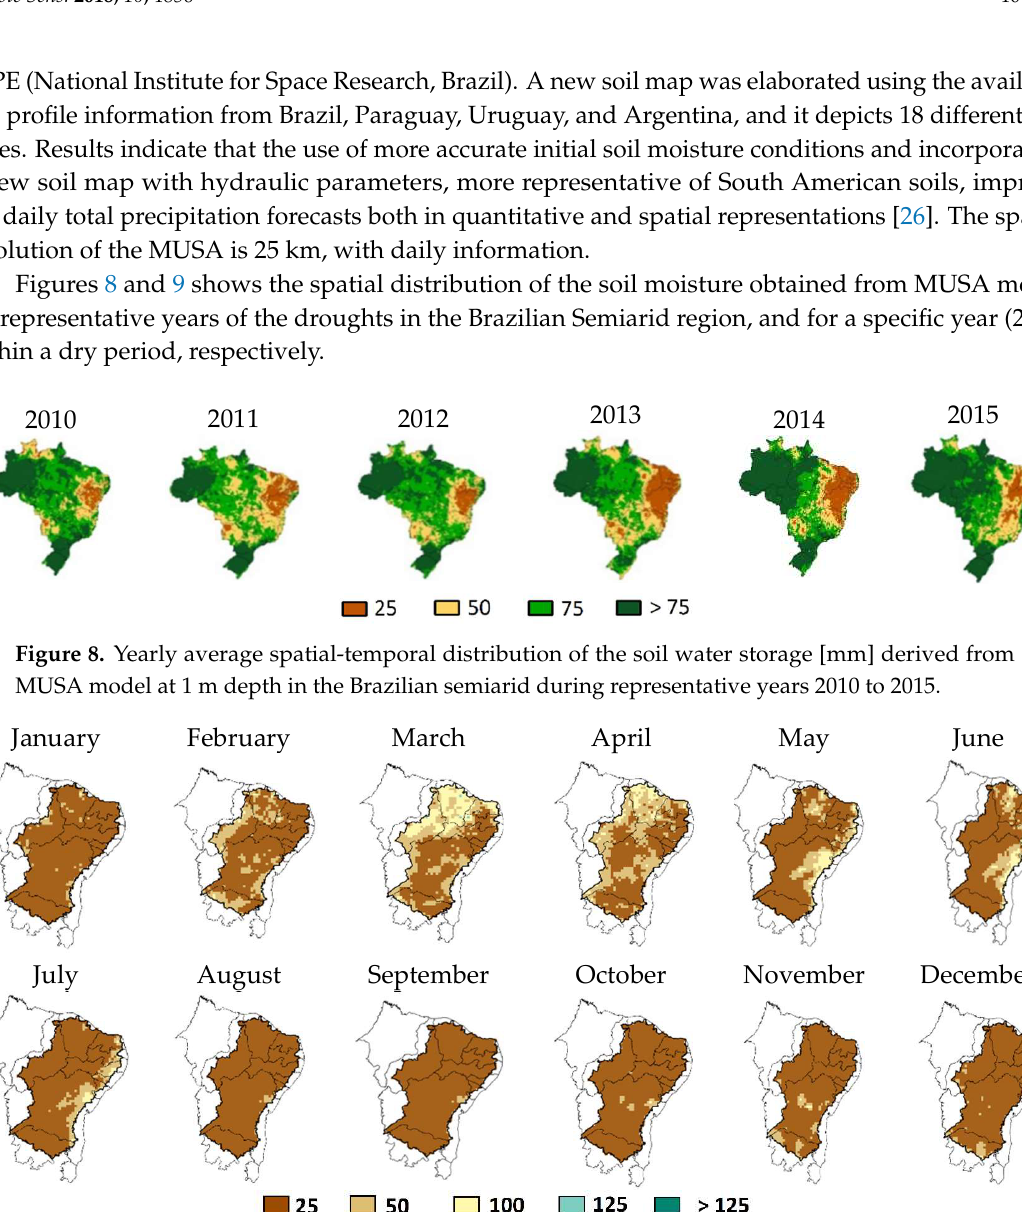
Figure 10. Monthly average spatial-temporal distribution of soil moisture (mm) derived from MUSA model during 2015 year (January to November) and TDS-1 GNSS-R reflectivity (all incidence angles).